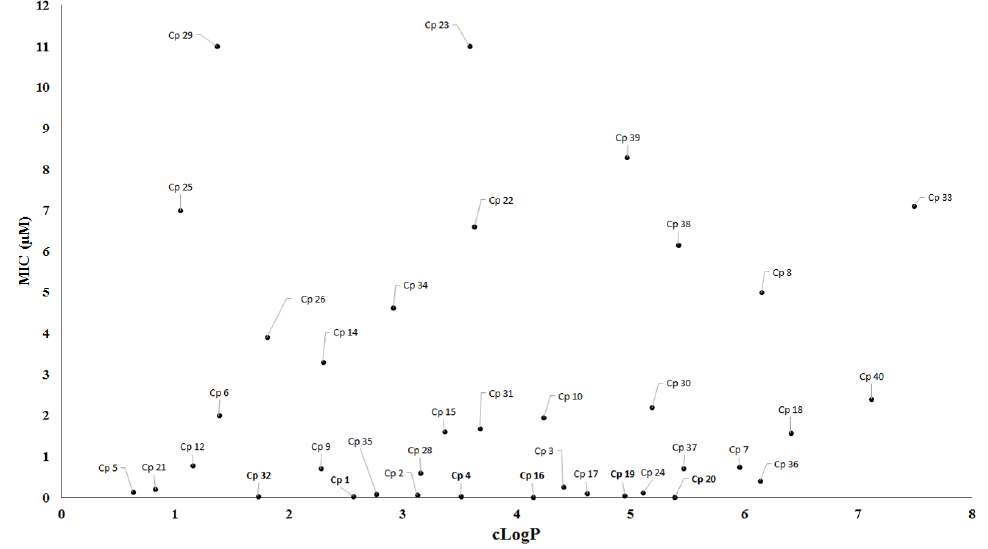
Figure 14. Correlation between MIC values and cLog P for the compounds. cLogP: calculated partition coefficient.